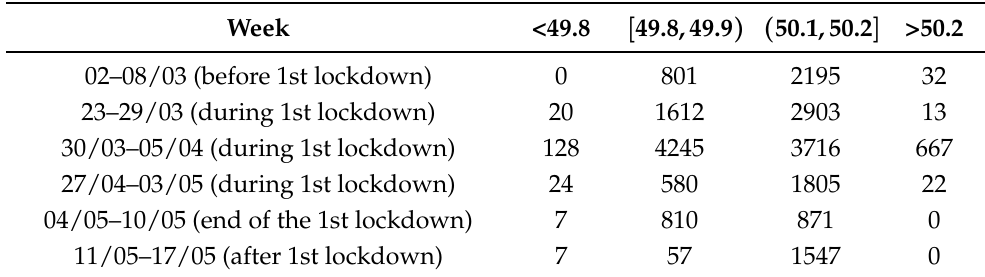
Table 5. Duration [in sec] of frequency deviations [in Hz] before and during the COVID-19